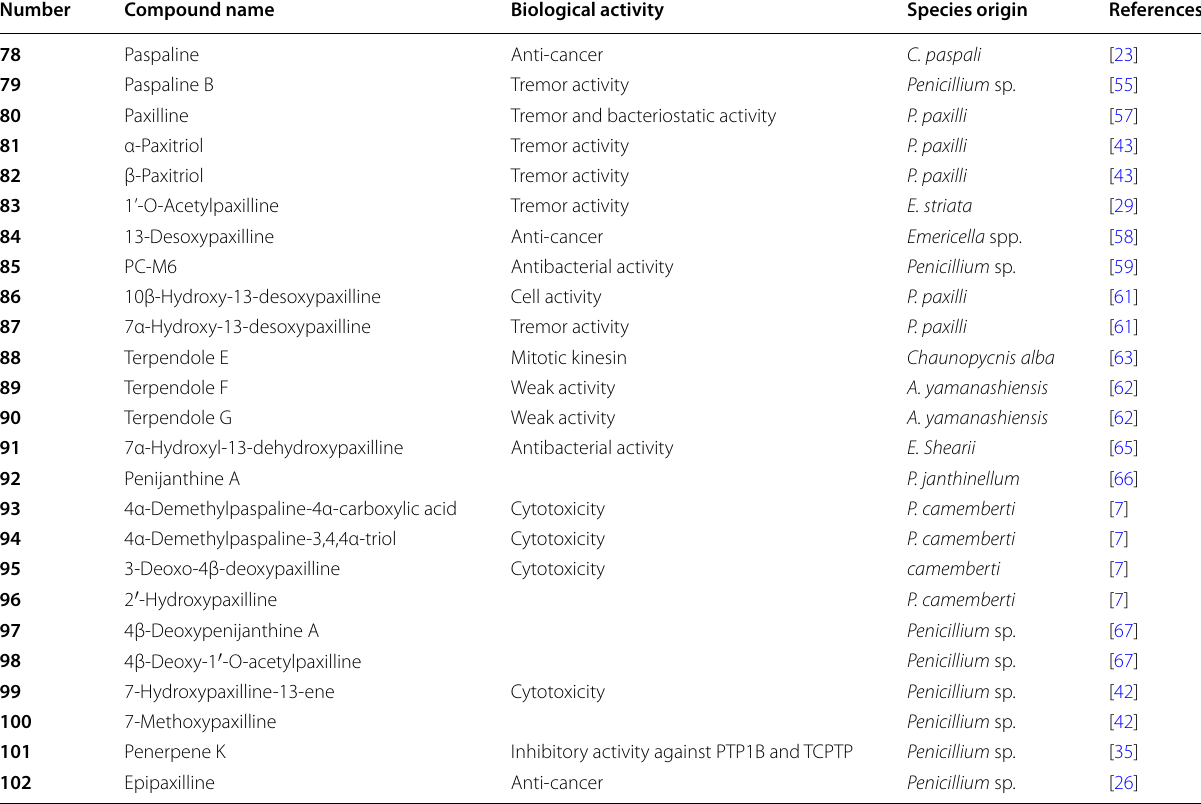
Table 7 Name, bioactivities and source of compounds with only paspaline